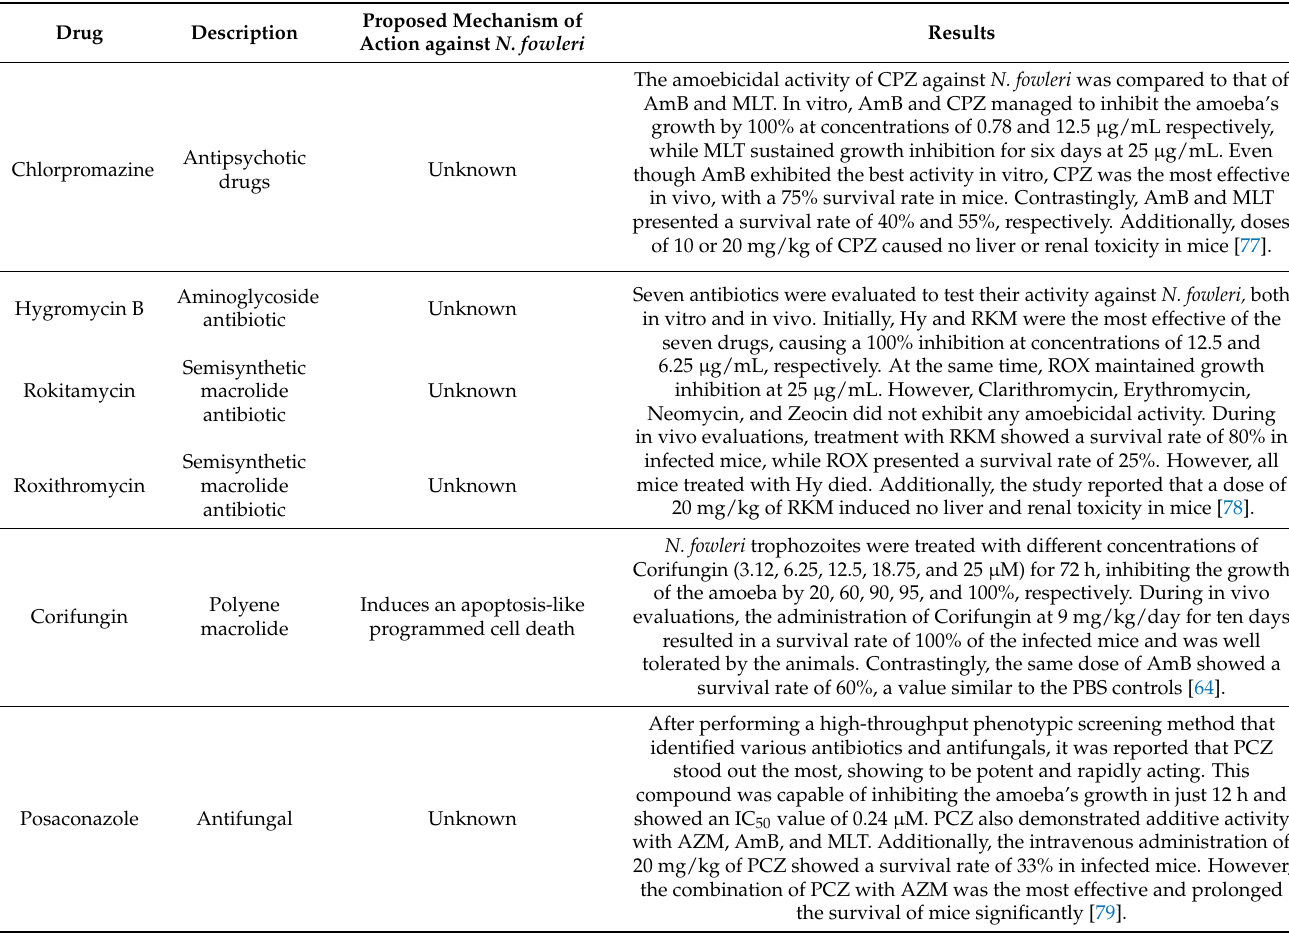
Table 2. Drugs being studied in vivo to determine their amoebicidal activity against N. fowleri .